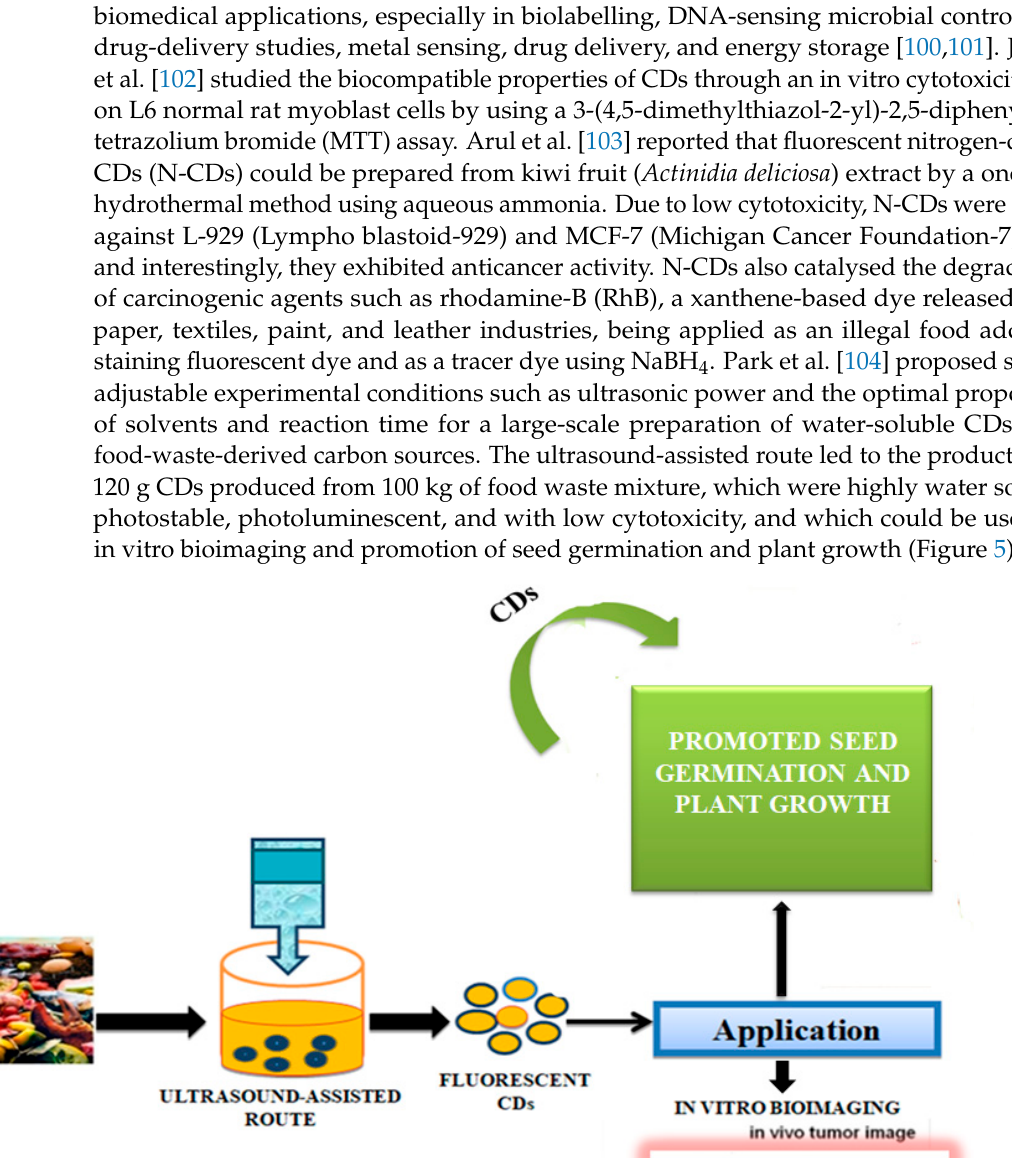
Figure 6. Synthesis of carbon dots from the watermelon peels. The CDs were successfully applied to HeLa cell imaging, as described in [105].